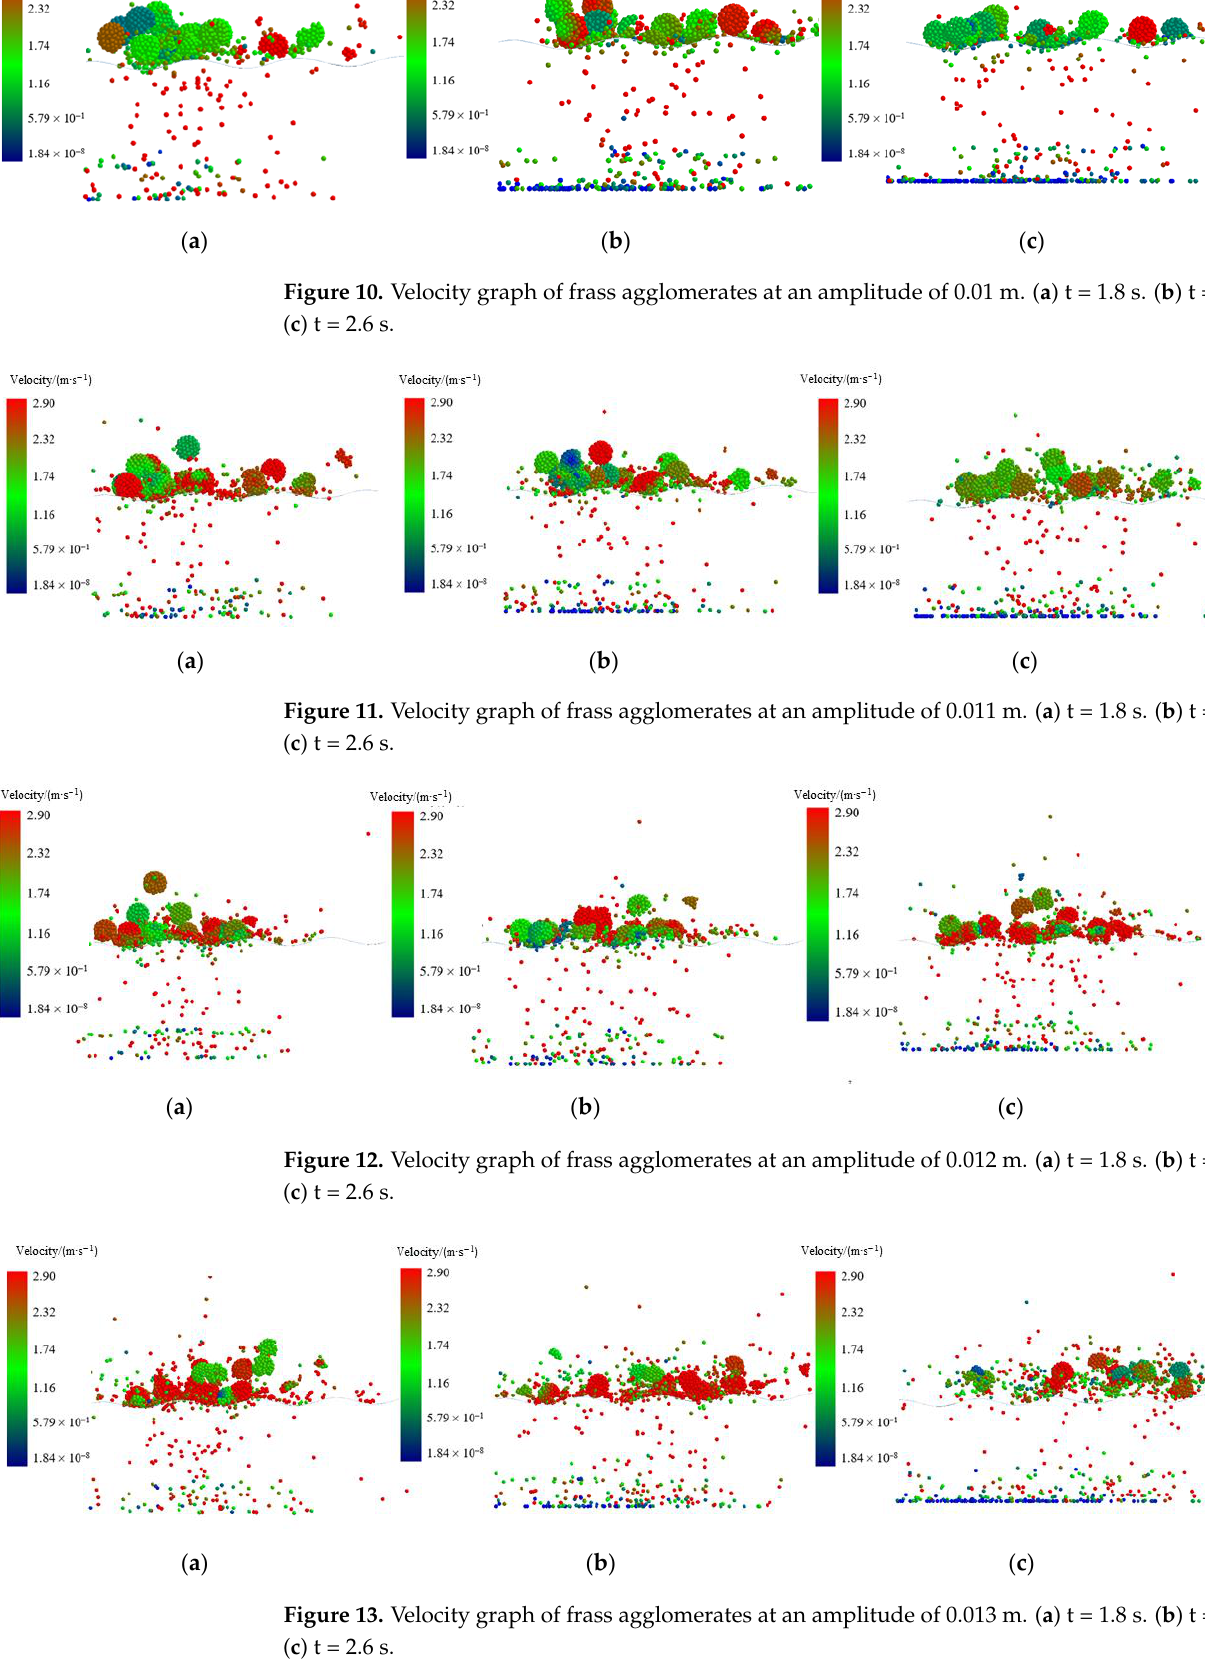
( c ) Figure 14. Velocity graph of frass agglomerates at an amplitude of 0.014 m. ( a ) t = 1.8 s. ( b ) t = 2.2 s. ( c ) t = 2.6 s. As depicted in Figures 10 – 14, the overall velocity of the frass agglomerates was higher when the agglomerates were being thrown off the falling section of the wave crest – trough. Moreover, once they reached the wave trough, they were promoted to climb with the increasing section of the wave trough – crest, and the velocity was slower at this point. Afterward, if they reached the wave crest, they were thrown back to the wave trough by